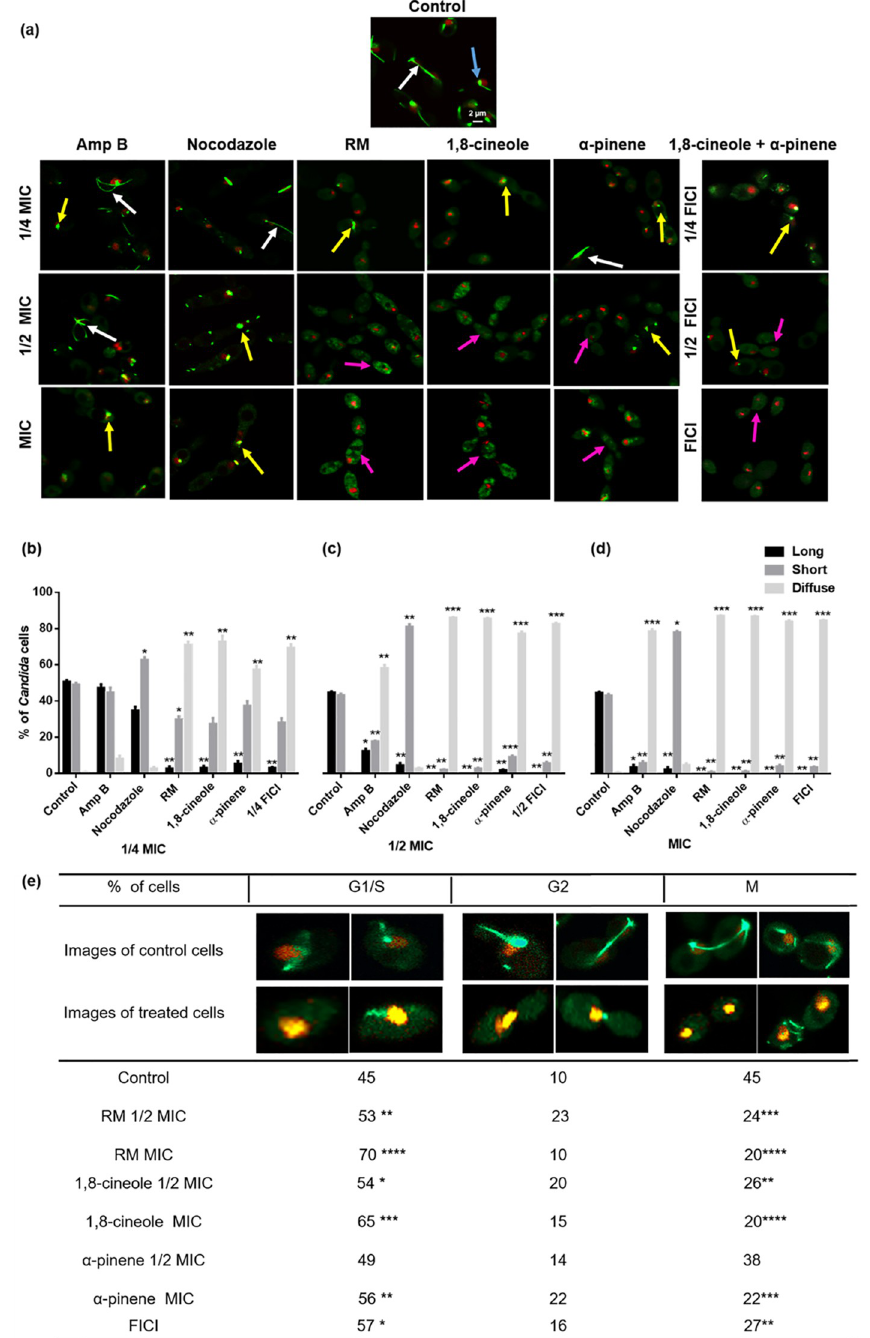
Fig 6. Effects of RM oil, 1,8-cineole, and α -pinene on C . albicans RSY150 microtubule formation and cell cycle phases. (a) The majority of cells (90–95%) treated with RM oil and its components at 1/2 MIC and MIC show diffuse tubulin (purple arrows), compared to untreated controls with normal spindle formation during mitosis (long MTs (white arrows) and short (blue arrows) MTs). Cells exposed to the positive control, nocodazole at 1/2 MIC and MIC had concentrated spots of green fluorescence (yellow arrow) similar to EO(C)-treated cells at 1/4 MIC. Images were collected by LSCM (Tub2-GFP λ ex = 488 nm; λ em = 512 nm and Htb-RFP λ ex = 543 nm; λ em = 605 nm). Scale bar for control is 2 μ m and represents the scale for all images. (b–d) Bar graphs of β -tubulin arrangement (long MT, short MT, diffuse). (e) Cell cycle (S/G1, G2, or M phase) frequency (%) following exposure to RM oil, 1,8-cineole, α -pinene at 1/2 MIC and MIC and the two components at FICI show arrest at the G1/S phase. Data are presented as the mean ±